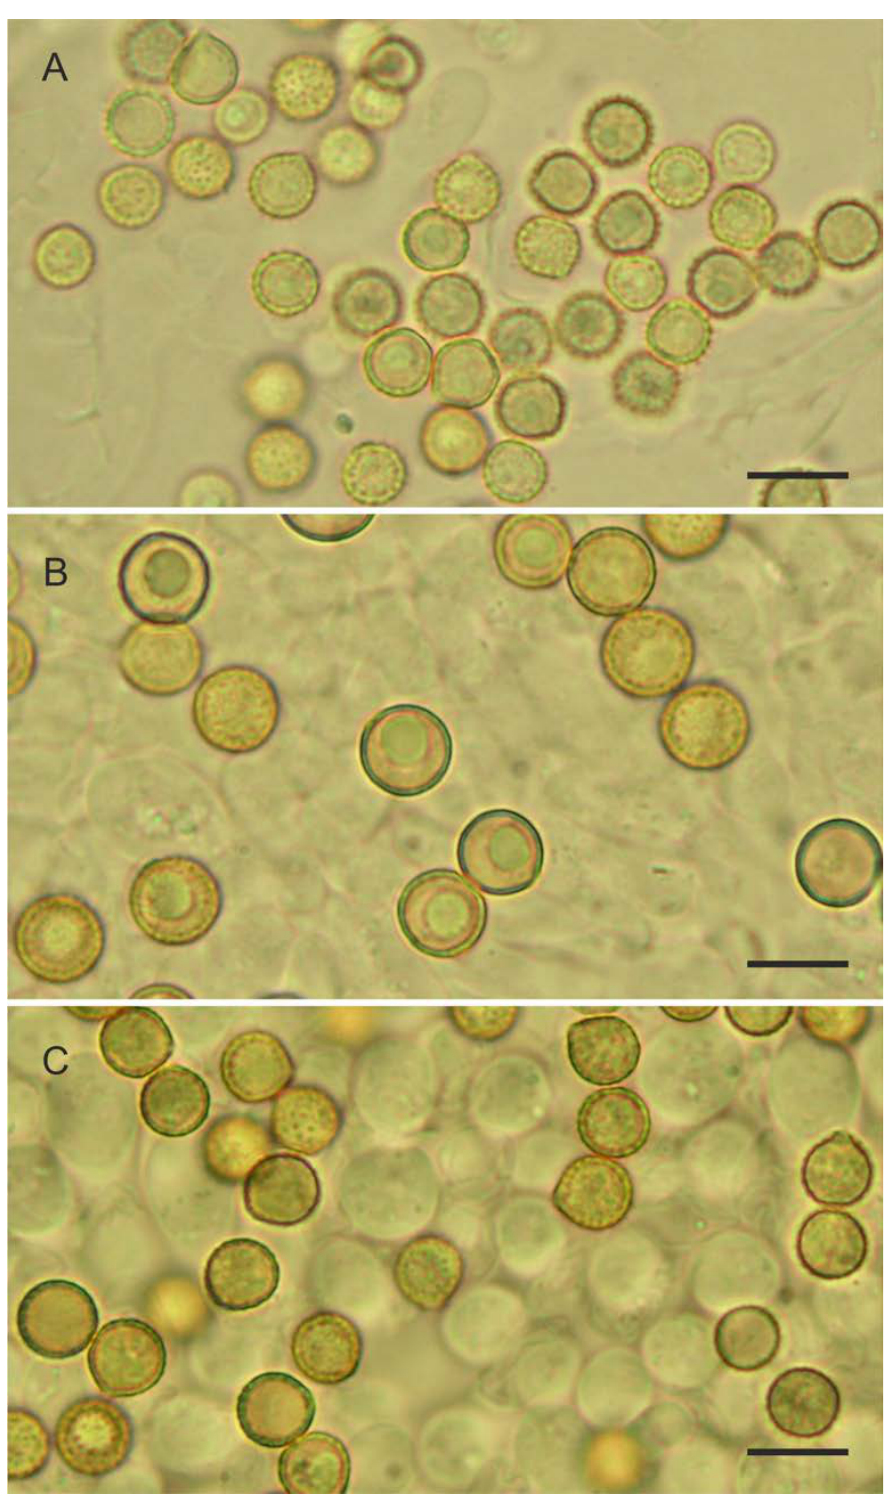
Figure 5. Light microscopic photos of basidiospores. ( A ) Crepidotus applanatus (SLO 2573), ( B ) C. malachius (SLO 479), ( C ) C. pini (SLO 2579). Scale bar = 10 μm.